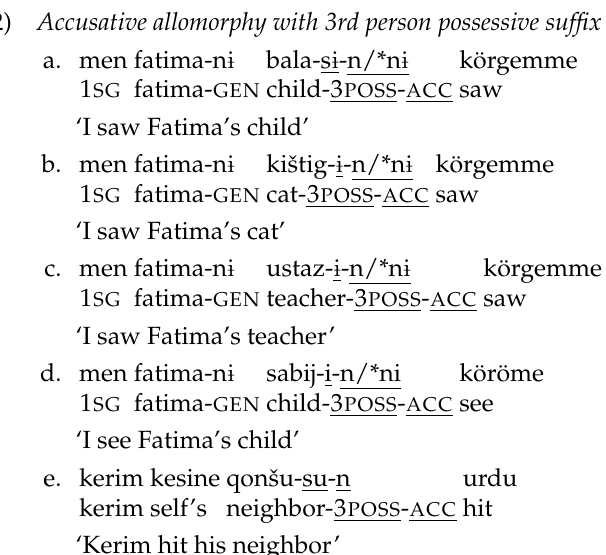
turad 1 stands kištig-i cat-3 POSS turad 1